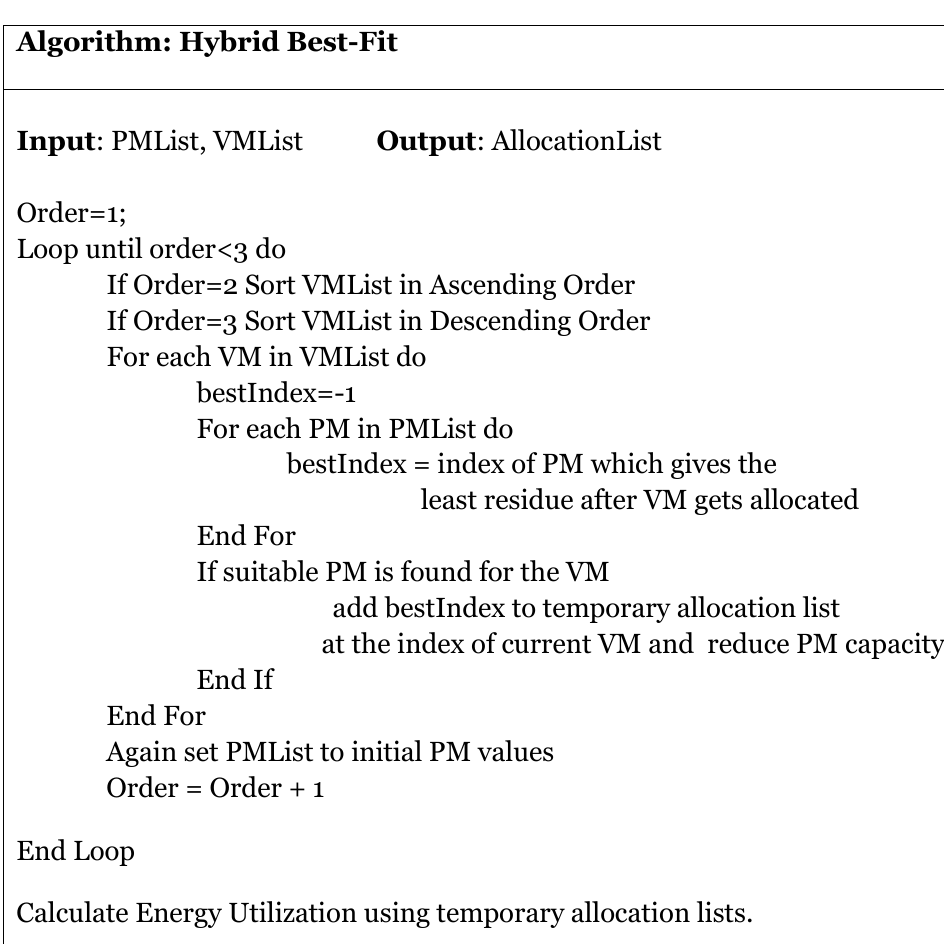
Figure 2. Proposed Hybrid Best-Fit (HBF) heuristic workflow